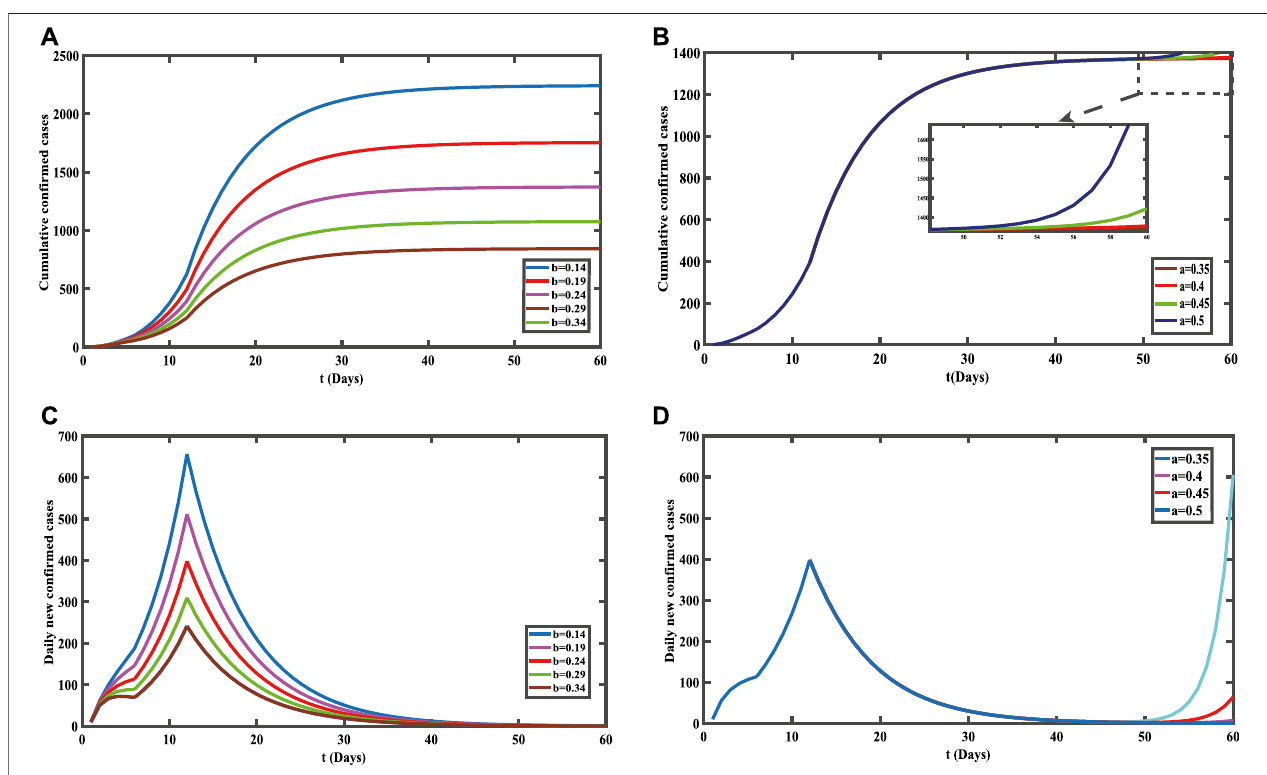
FIGURE 6 | In fl uence of population migration on COVID-19 cases in Guangdong Province before and after the Spring Festival. (A) Cumulative con fi rmed cases before the Spring Festival. (B) Cumulative con fi rmed cases after the Spring Festival. (C) Daily new con fi rmed cases before the Spring Festival. (D) Daily new con fi rmed cases after the Spring